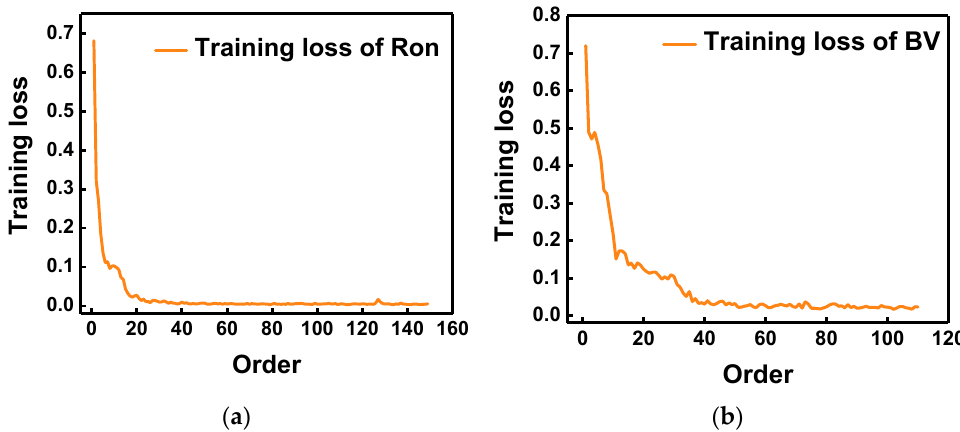
Figure 6. Training loss in the training process. ( a , b ) are training loss of Ron and BV, respectively. With the increase in the number of iterations, the loss in the training process gradually decreases and finally becomes stable.